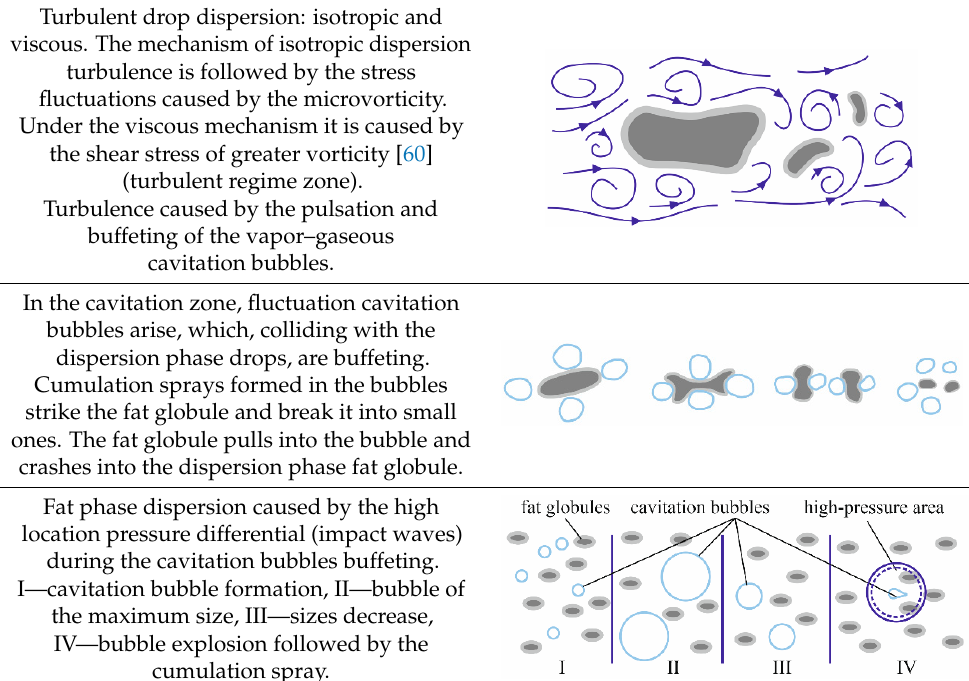
(turbulent regime zone).